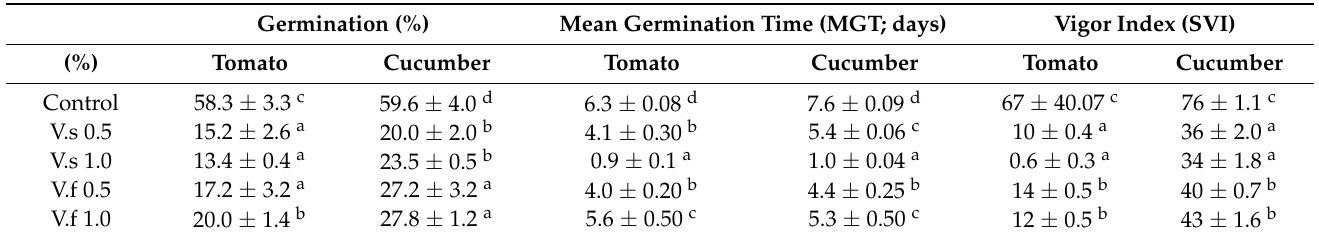
Table 2. Effect of aqueous extracts of Verbesina sphaerocephala and Verbesina fastigiata on germination percentage, mean germination time, and seed vigor index.